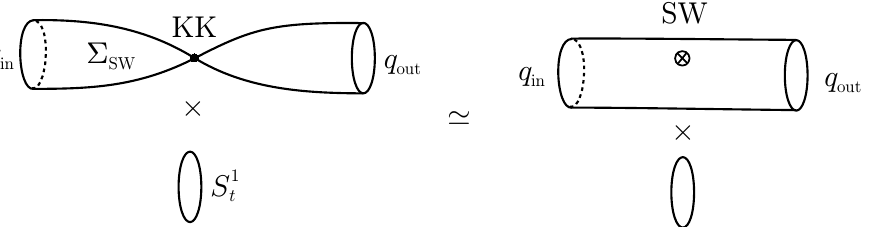
Figure 5 . The space-time of T [ M 3 ]: (cid:6) SW (cid:2) S 1 where (cid:6) SW is the Seiberg-Witten